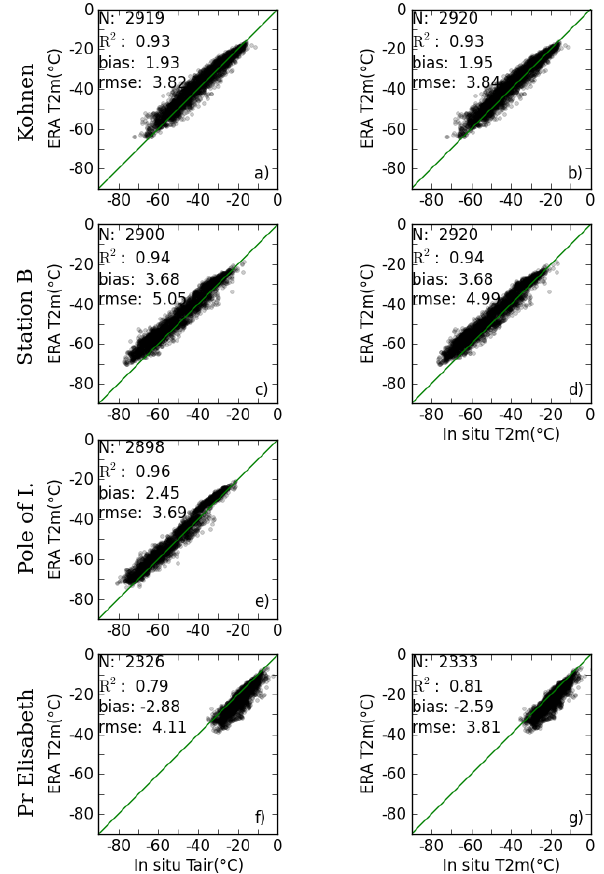
Figure 7. Left column: comparisons of ERA-i T 2m and in situ T air at (a) Kohnen (2892ma.s.l., z ERA − i = 2867m), (c) Plateau Station B (3619ma.s.l, z ERA − i = 3617m), (d) Pole of Inaccessi- bility (3718ma.s.l., z ERA − i = 3746m) and (f) Princess Elisabeth (1372ma.s.l, z ERA − i = 1316m) during 2009. Right column: com- parisons of ERA-i T 2m and in situ T 2m at (b) Kohnen, (d) Plateau Station B and (g) Princess Elisabeth during 2009. The green line represents the 1:1 line.